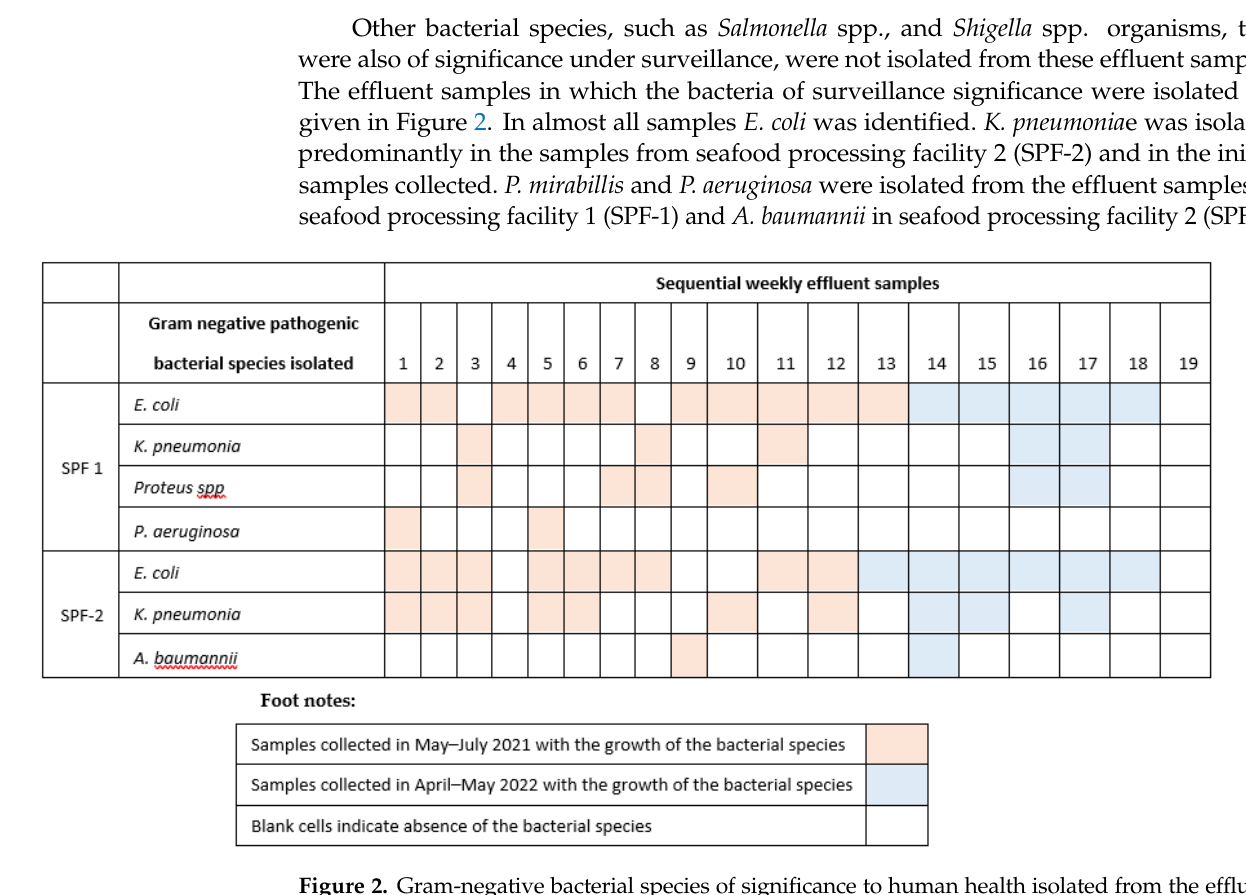
Figure 2. Gram-negative bacterial species of significance to human health isolated from the effluent samples collected from the two seafood processing facilities (SPF) in Tema, Ghana during 2021 and 2022.